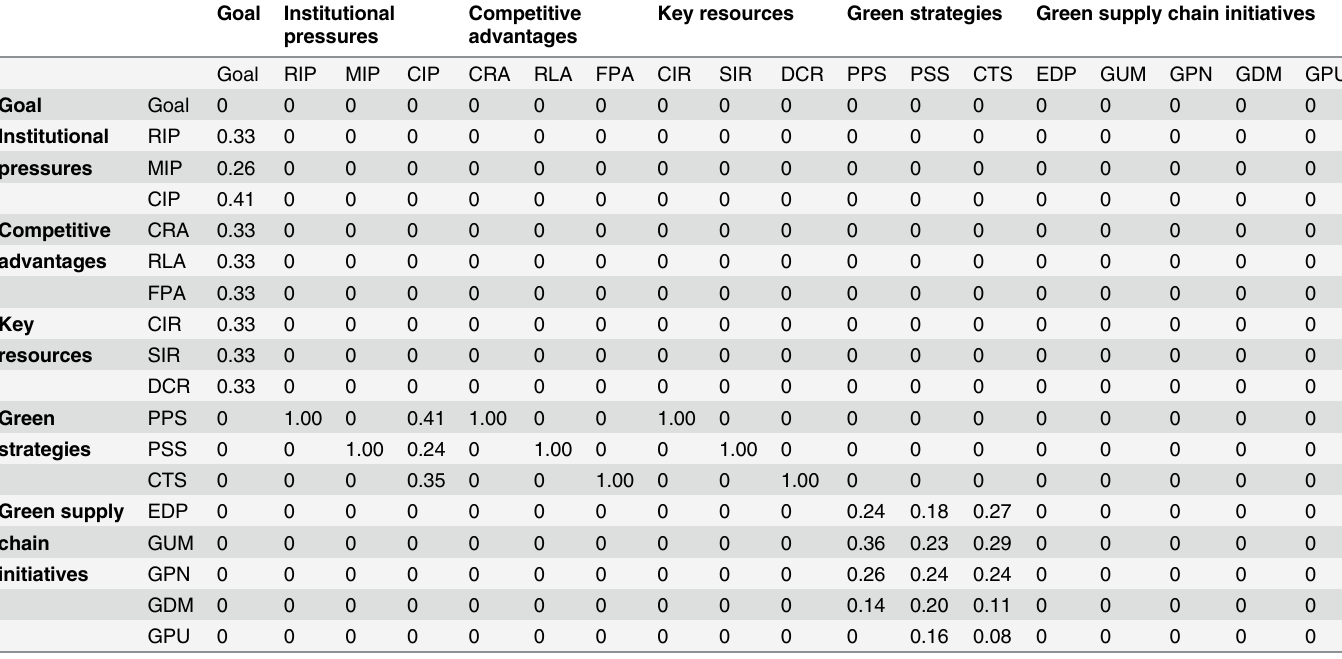
Table 8. Unweighted supermatrix. Goal Institutional